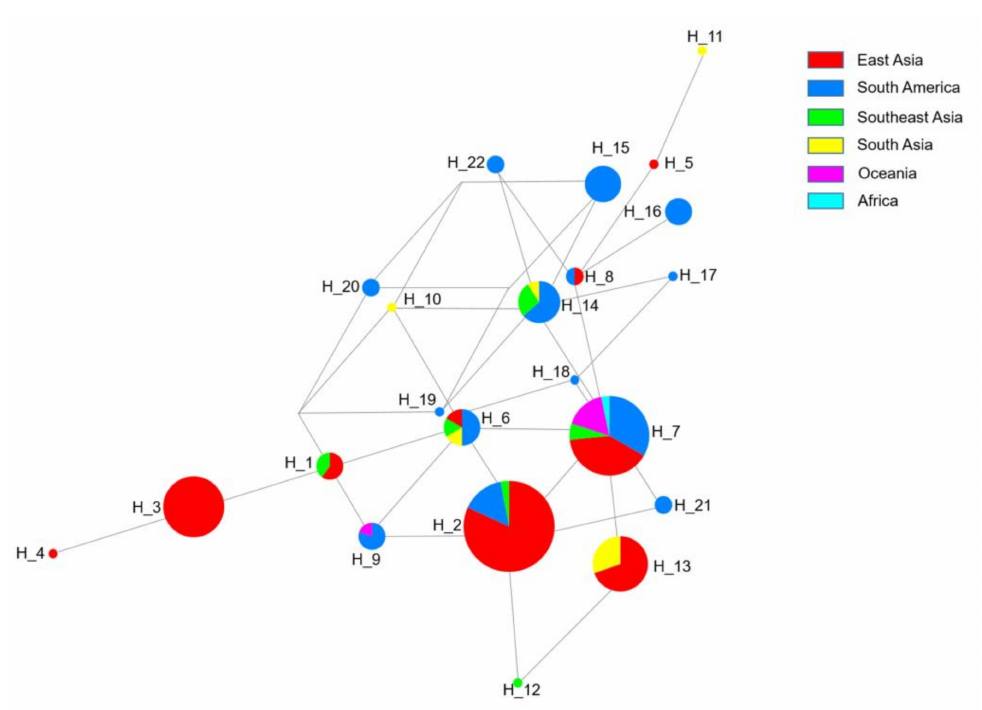
Figure 4. The haplotype network was created using 166 pvmrp1 nucleotide sequences by the median- joining method in the NETWORK v5.0 program. The size of the circles indicates the haplotype frequency, and the color shows the geographical origin of the sequences. The lines between haplotypes display mutational steps.